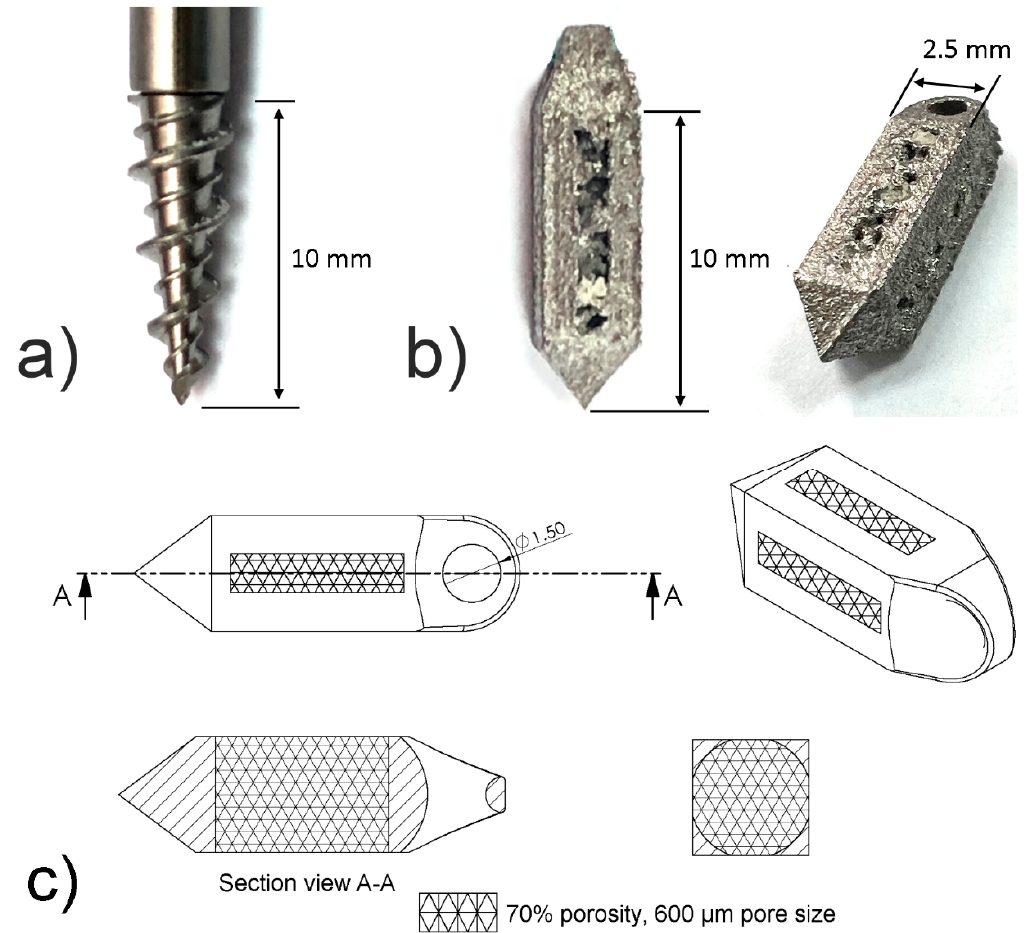
Figure 1. ( a ) Commercially-available threaded suture anchor (TwinFix™ Ti 3.5, Smith & Nephew, Andover, MA, USA); ( b ) custom-made threadless suture anchor with rectangular cross-section; ( c ) design drawing of the custom-made threadless suture anchor.